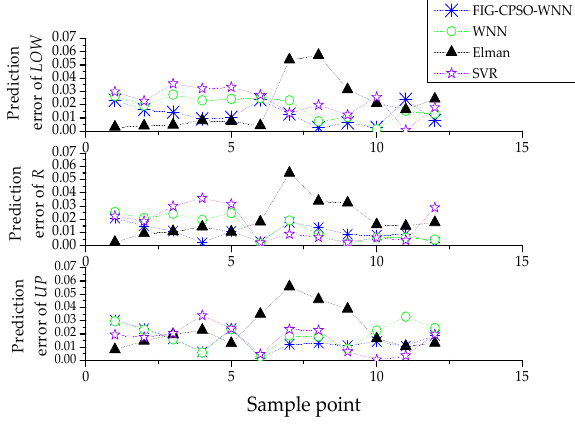
Figure 6. Comparison of prediction error.